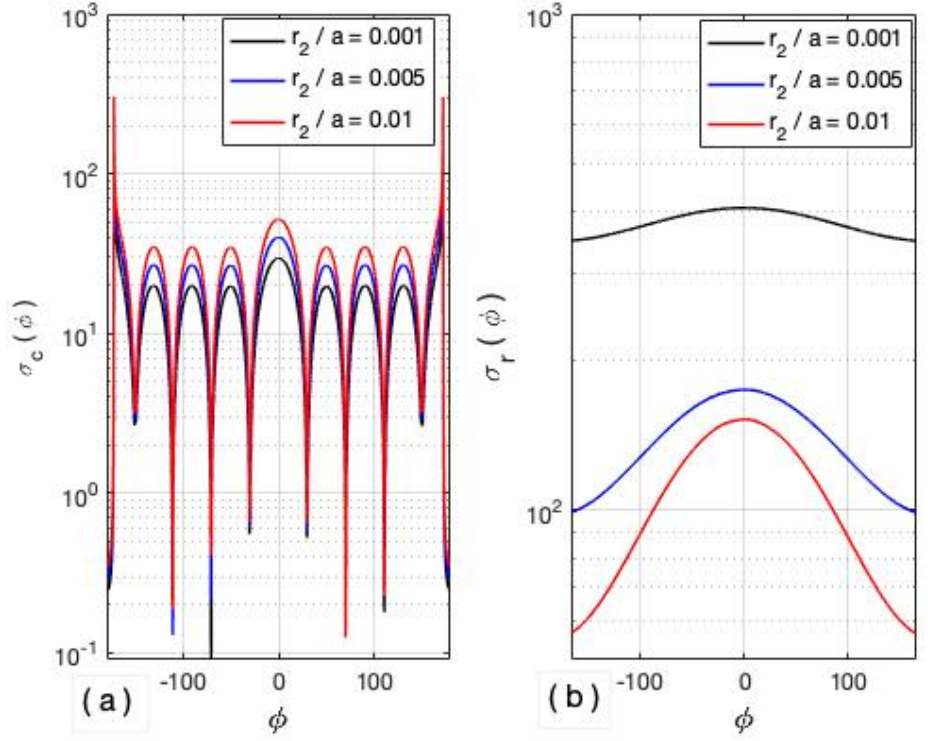
Figure 14. SCD distribution 𝜎 (cid:3030) (𝜙) and 𝜎 (cid:3045) (𝜙) under excitation of the 𝑇𝑀 (cid:2869)(cid:2871) mode (𝑤 𝑎⁄ = 0.25) : ( a ) cavity; ( b ) rod.